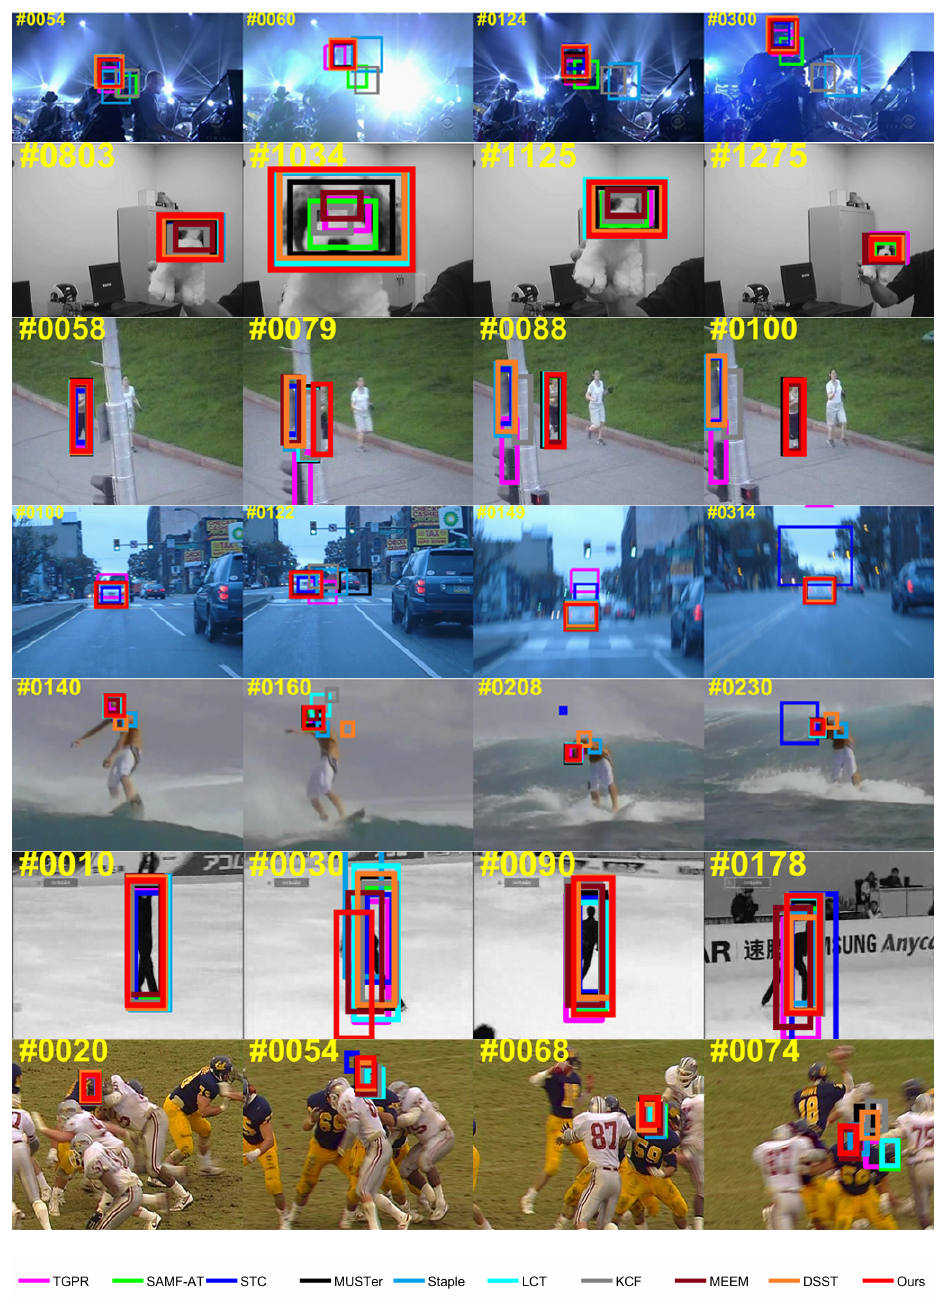
Figure 7. Qualitative evaluation of our algorithm and nine other state-of-the-art trackers on seven sequences (from top to bottom: Shaking, Dog1, Jogging1, BlurCar3, Surfer, Skater2 and Football1 ). These sequences correspond to the attributes IV, SV, OCC, MB, FM, OPR and BC,